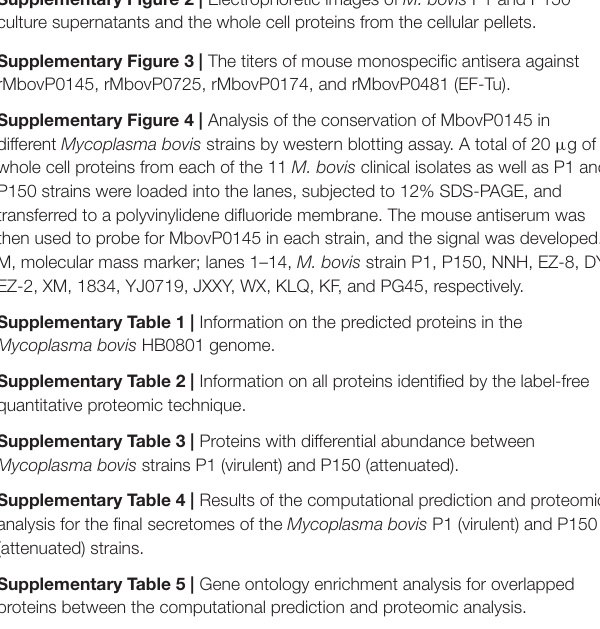
Supplementary Table 6 | The specificity of